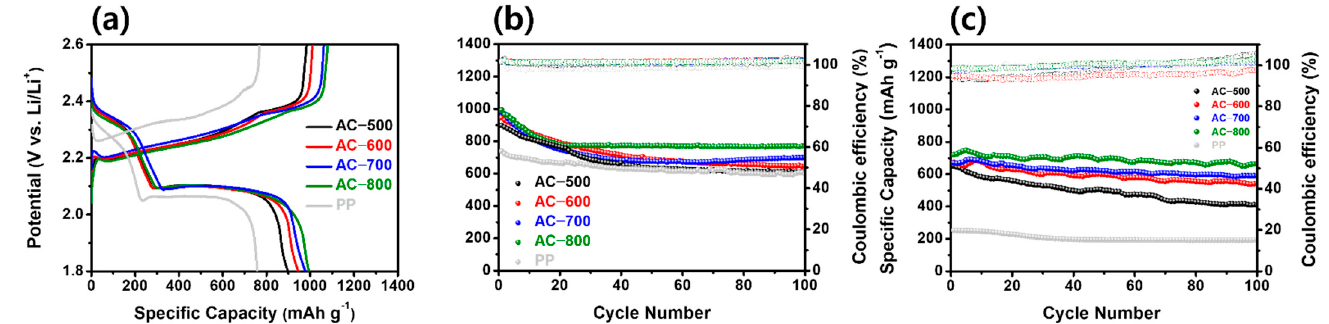
Figure 8. ( a ) Characteristic charge-discharge curves of the Li/S cells with AC samples as functional separators and a pristine PP separator measured at a current density of 0.1 C of the first cycle in the potential range of 1.8–2.6 V vs. Li/Li + . ( b ) Cycling performance of the Li/S cells recorded at a current density of 0.1 C for 100 cycles (The transparent dots are Coulombic efficiencies of the samples). ( c ) Cycling performance of the Li/S cells recorded at a current density of 0.5 C for 100 cycles.